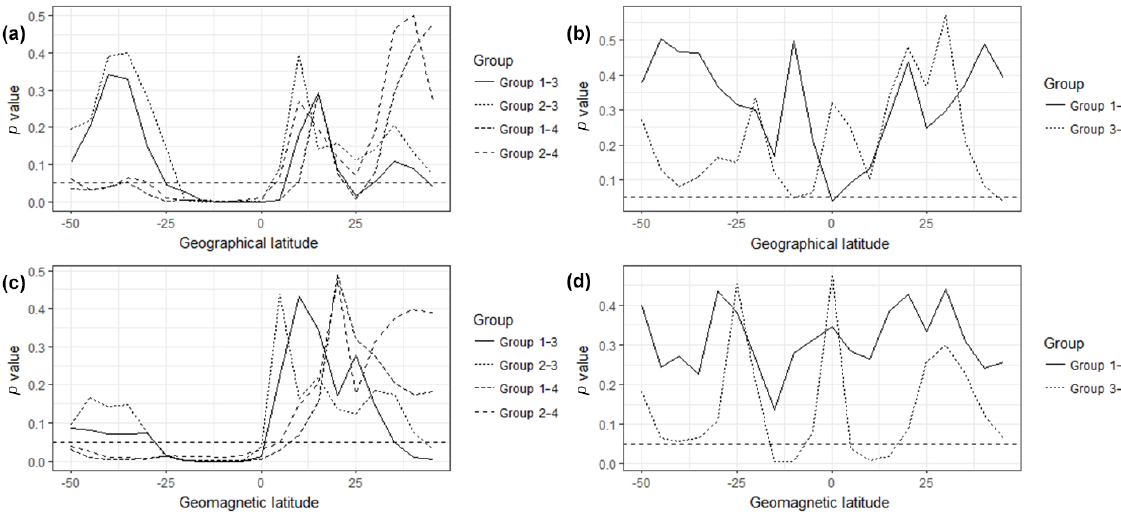
Figure 4. Variations in p values with geographical and geomagnetic latitude. Table 3. Permutation test results of ascending data in the 20 geomagnetic latitudinal